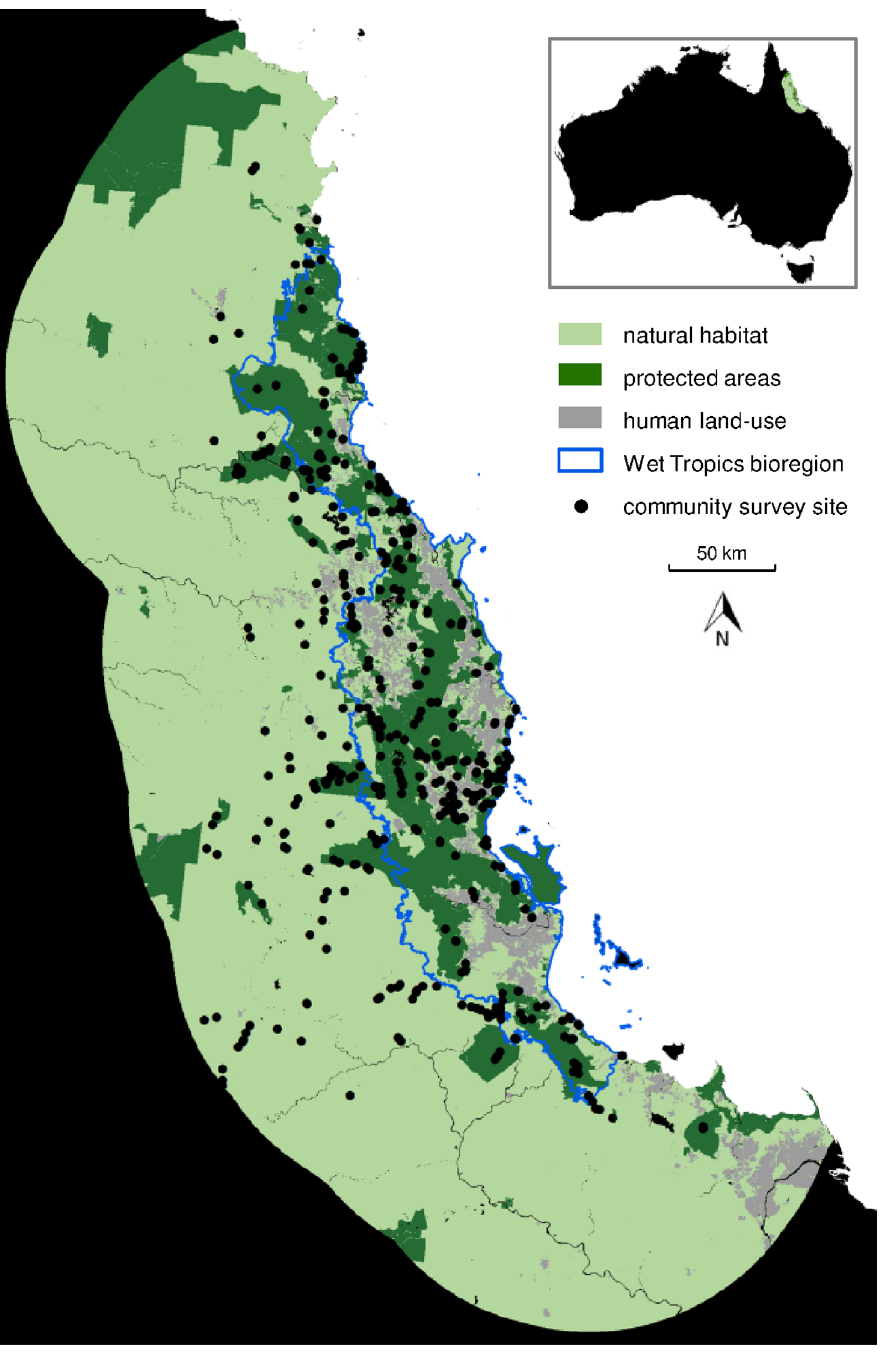
Figure 1. The study region. The study region, being the Wet Tropics Bioregion (blue line) and 100 km of surrounding area, in Queensland, Australia (inset). Protected areas (dark green), unprotected natural habitat (pale green) and modified habitat (grey) are shown, along with the locations of the 527 plant community surveys used in our analyses (black dots).